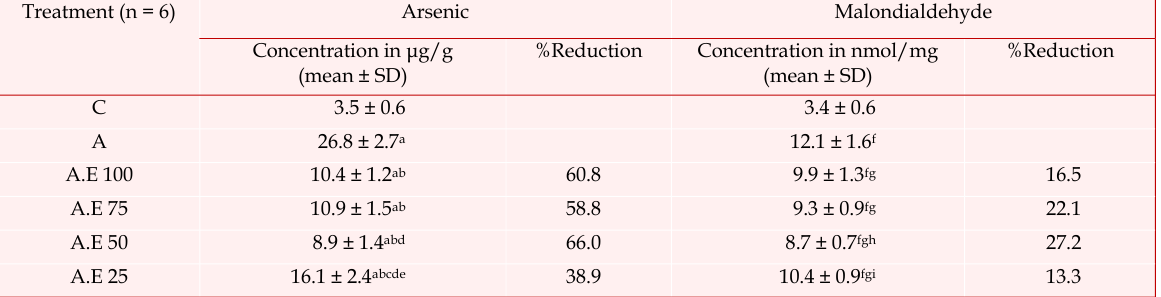
Effect of different concentrations of water hyacinth extract on arsenic and malondialdehyde level in rat liver